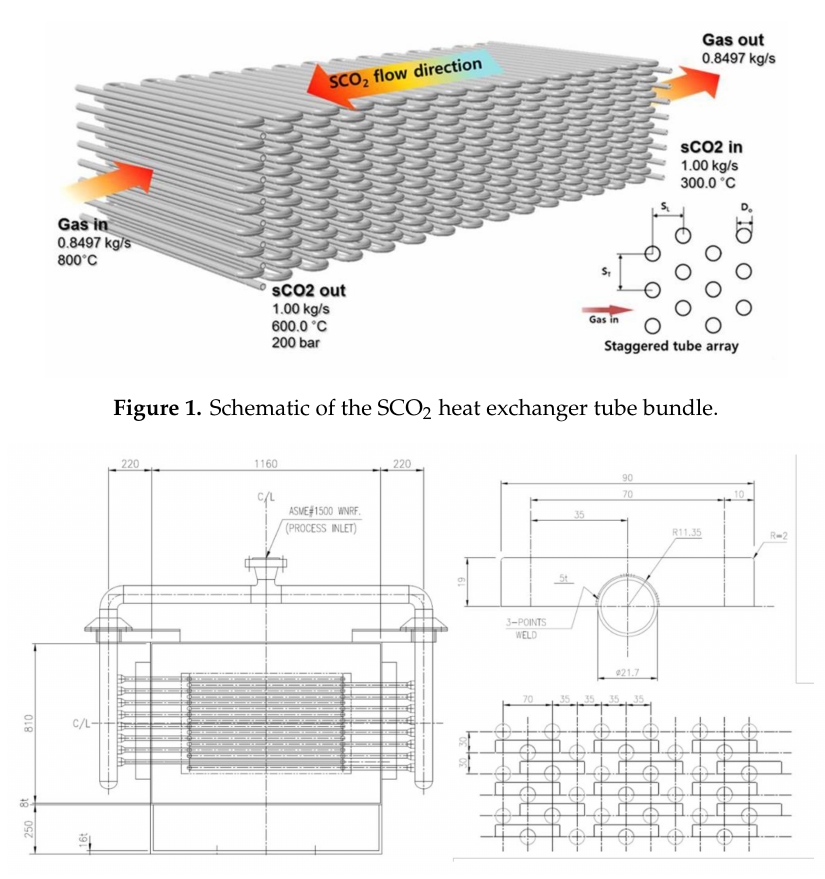
Figure 2. SCO 2 heat exchanger header, nozzle, and tube-supporting structure.